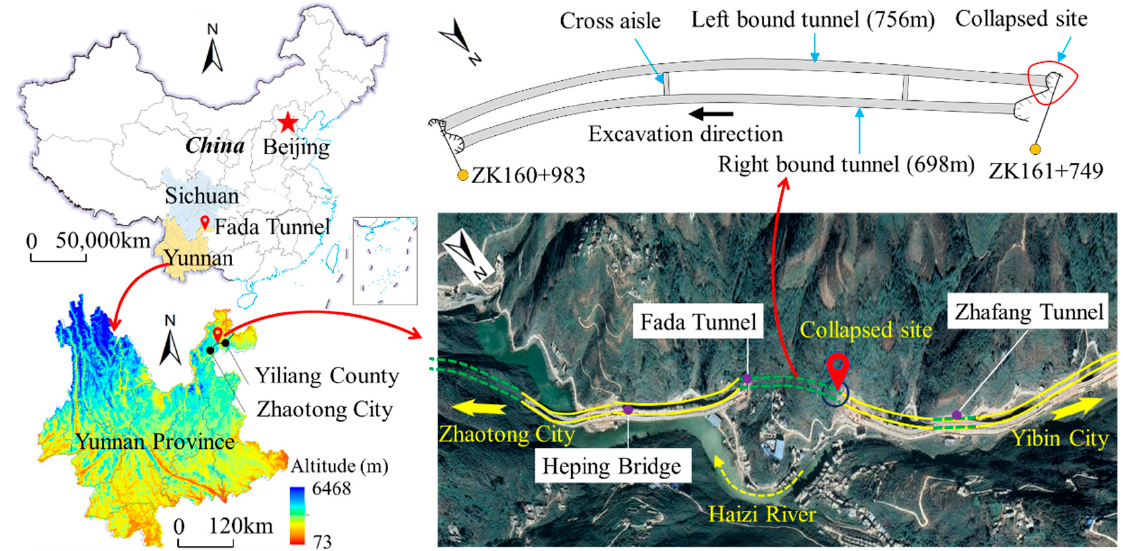
Figure 1. Location of the tunnel.